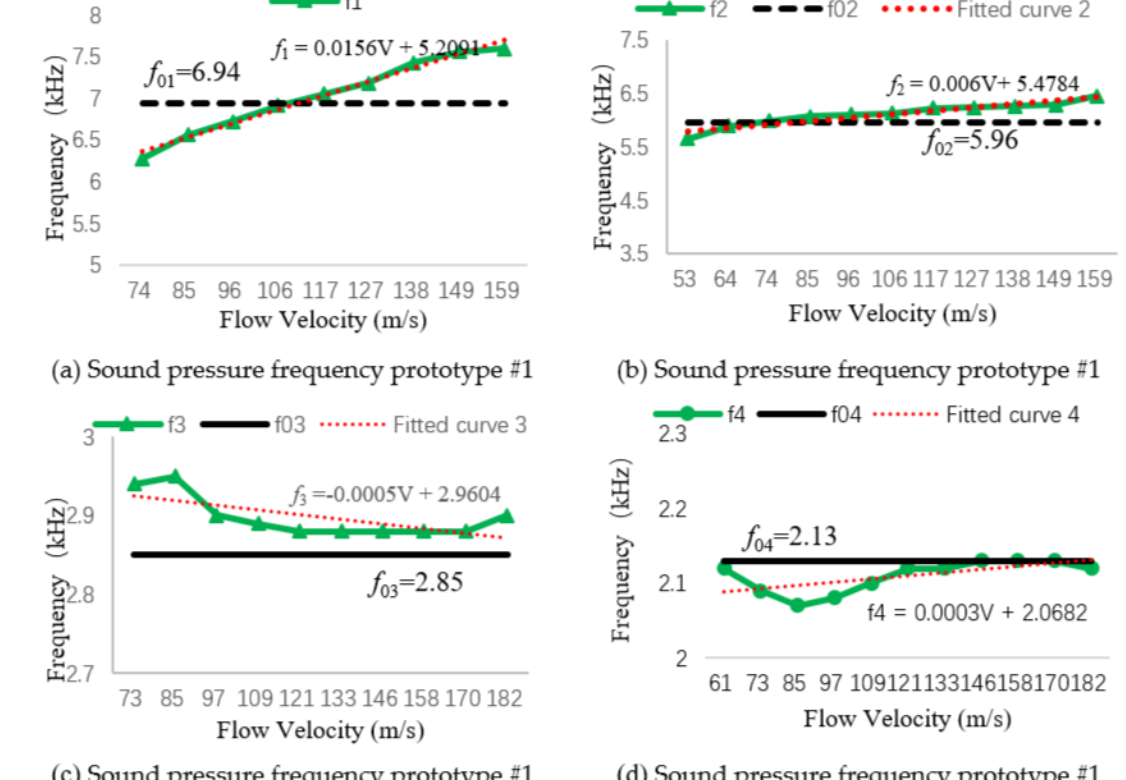
Figure 8. Sound pressure frequency and first-order resonant frequency.